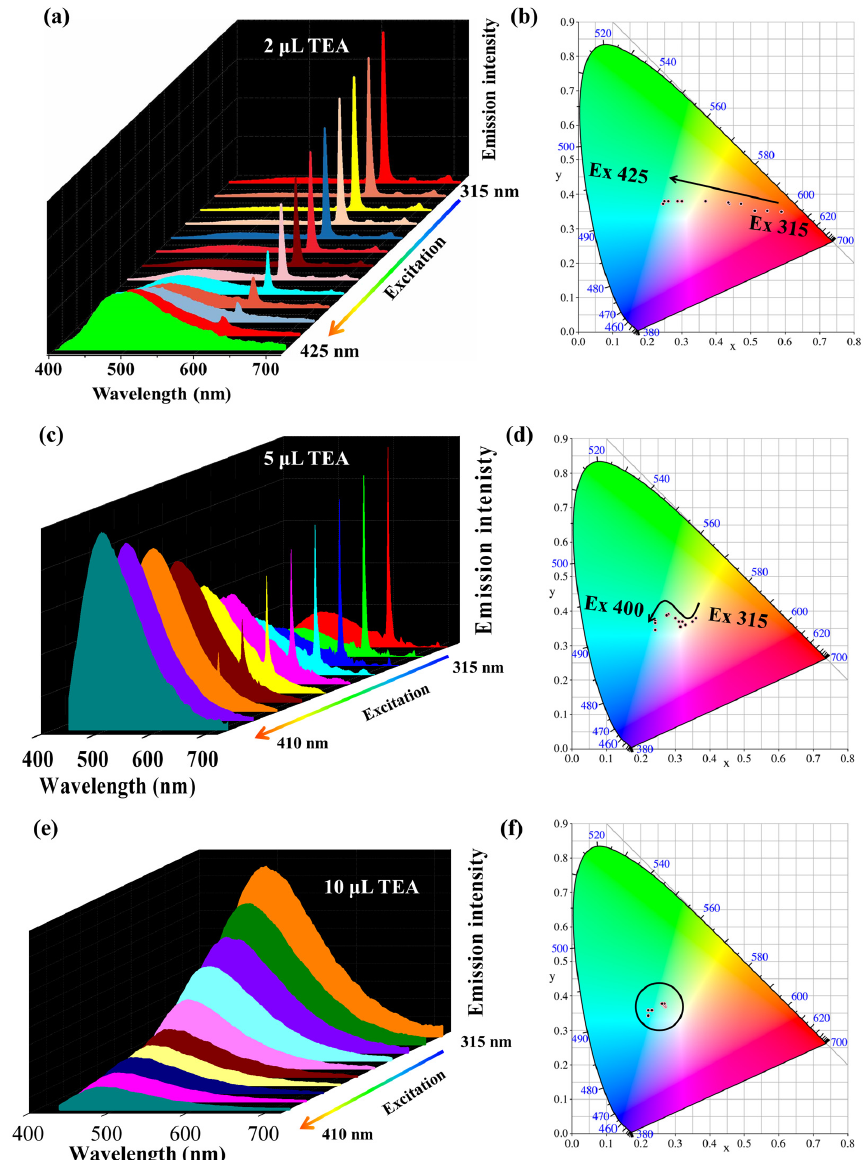
Figure 2. Emission spectra of complex 2 in DMSO solution (1 × 10 − 5 M) stimulated by 2 μ L ( a ), 5 μ L ( c ) and 10 μ L TEA (0.1 mM) ( e ) dependent on the excitations ( λ ex = 315 − 425 nm, each interval of 10 nm) at RT. ( b , d and f ) corresponding CIE graph dependent on the excitations.